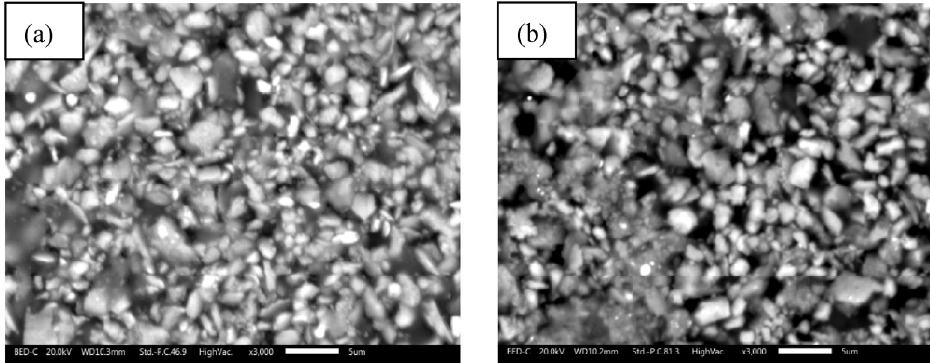
Fig. 7 SEM micrographs of fragments collected by the ELPI+ impactor (stage 12) from (a) FM4-BD1 and (b) FM4-BD2 systems.